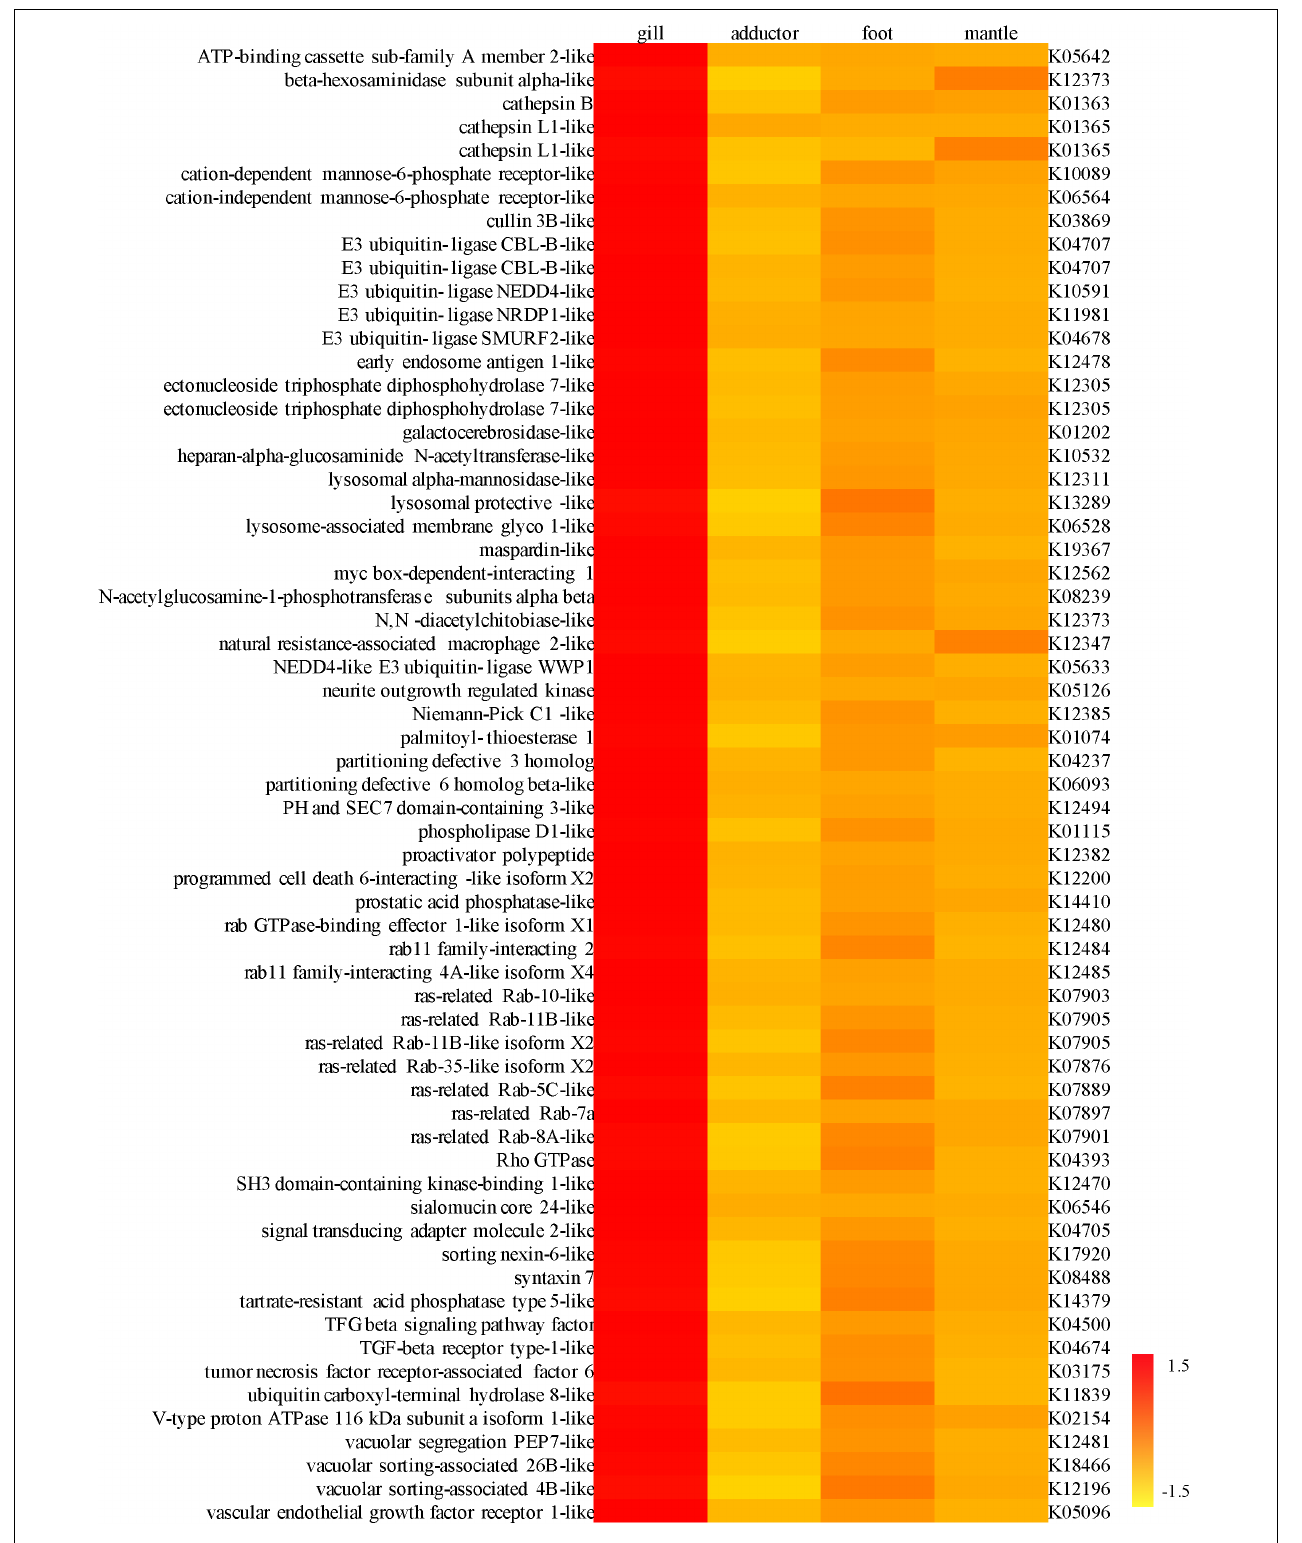
FIGURE 3 | A heat map showing the expression level of genes involved in endocytosis and the lysosome pathway, especially the Rab families of gene and genes encoding lysozymes, in the gill, adductor muscle, foot, and mantle of Archivesica marissinica (left: NR annotation; right: KEGG annotation).